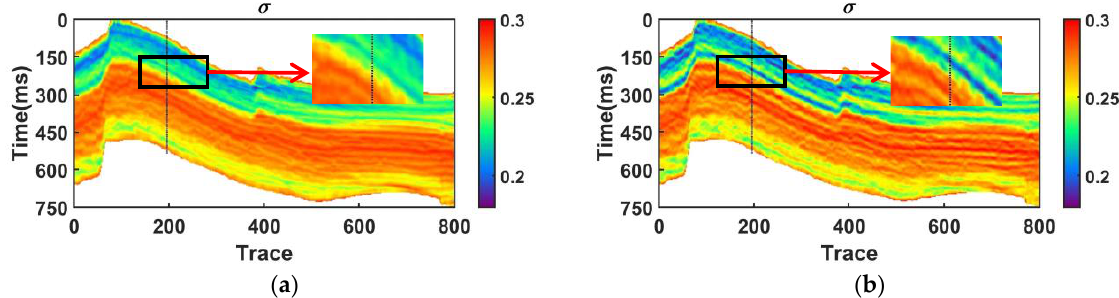
Figure 29. Poisson's ratio inversion results based on (a) traditional method and (b) reweighted Lp method.